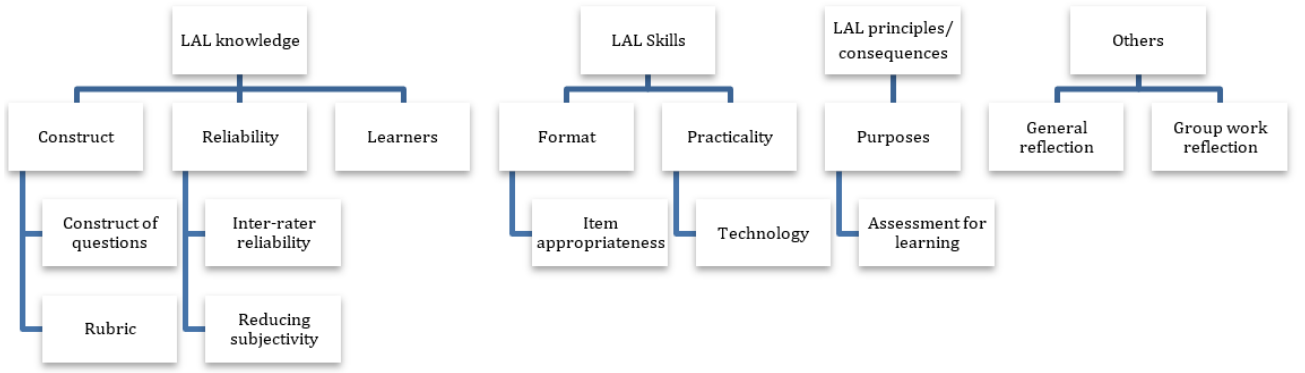
Figure 1. Themes and codes.